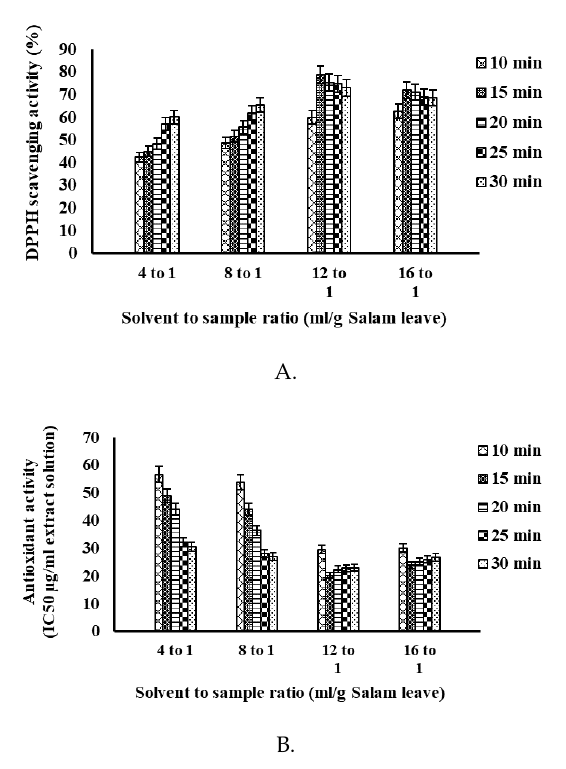
Fig. 1. A. DPPH scavenging activity graph and B. Antioxidant activity graph based on Salam leaf IC50. The colored bars show the variation in the extraction time of the Salam leaf material. The error bar that is affixed indicates a significant difference between treatments with a significance level of